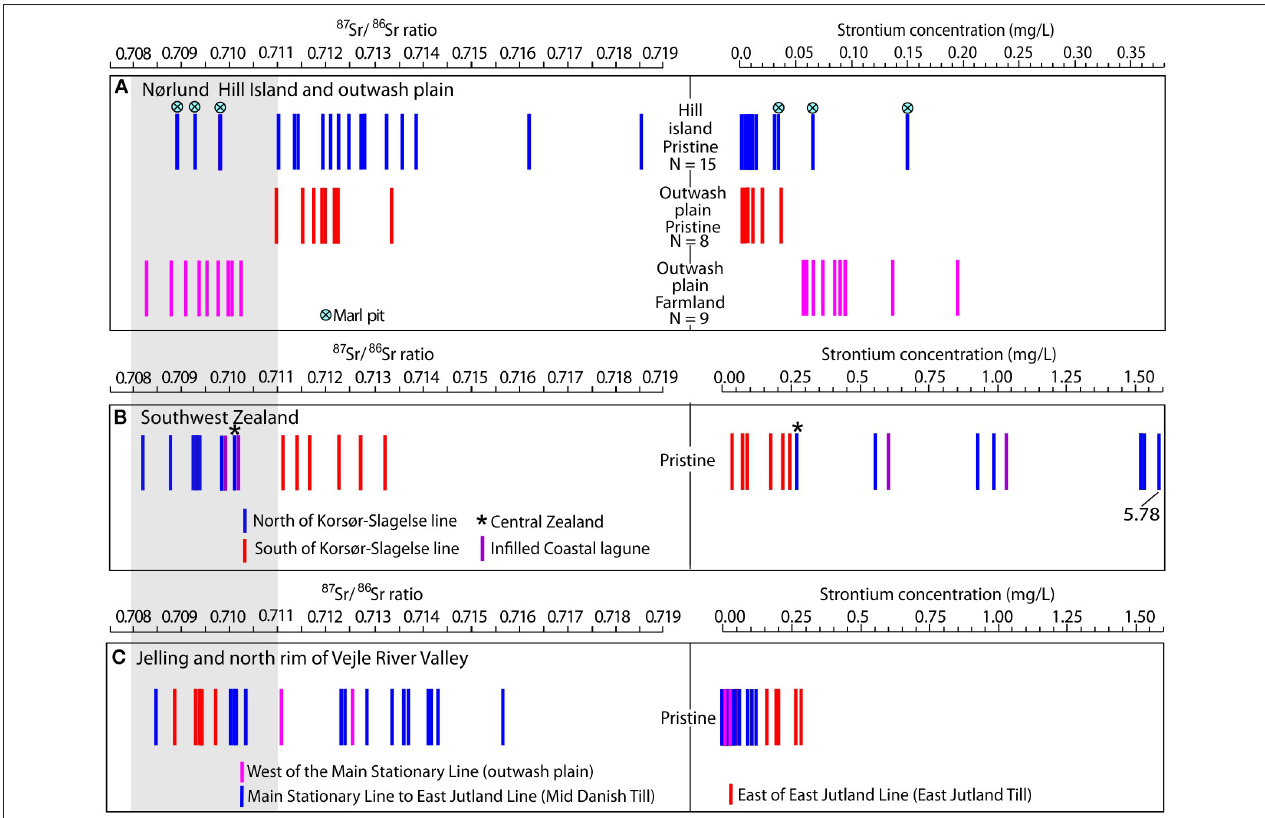
FIGURE 4 | 87 Sr/ 86 Sr ratios and strontium concentrations for all surface water samples in each of the three study areas: (A) S1; Nørlund hill island, (B) S2; Southwest Zealand and (C) S3; Jelling and Vejle River Valley. Each sample is represented by two vertical bars; one for the 87 Sr/ 86 Sr ratio and one for the strontium concentration. The samples of study area S1 in (A) are subdivided into two main groups: Samples from the hill island and samples from the outwash plain. The samples from the outwash plain are further subdivided into pristine sample and samples from farmland. For study area S2 (B) and S3 (C) we have analyzed only pristine samples. In study area S2, we distinguish between samples from within the glacial advance at 17,000 years (see Figure 5 , red and purple arrows) and samples from outside of this advance) ( Figure 5 , blue arrows). In study area S3, we mark the samples according to their geographical location (see Figure 7 ). Gray box to the left marks the 87 Sr/ 86 Sr isoscape for Denmark of Frei and Frei (2011). N = number of samples in each